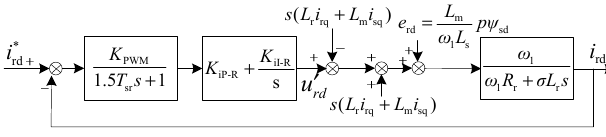
Figure 2. Control framework of inner current loop of RSC.